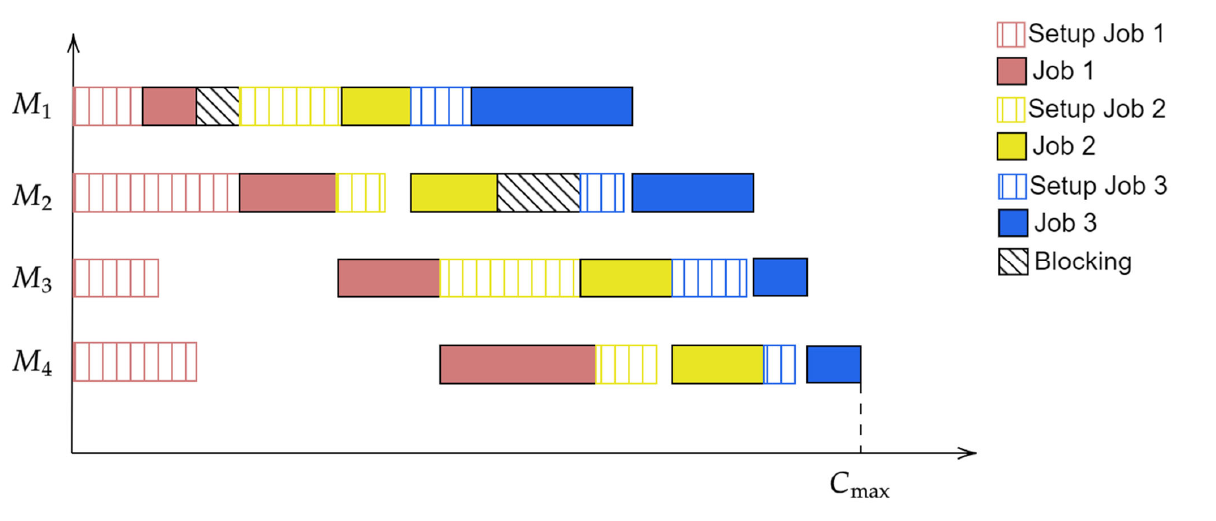
for 3 jobs and 4 , 𝑏𝑙𝑜𝑐𝑘 | 𝐶 max (cid:3036)(cid:3037)(cid:3038)